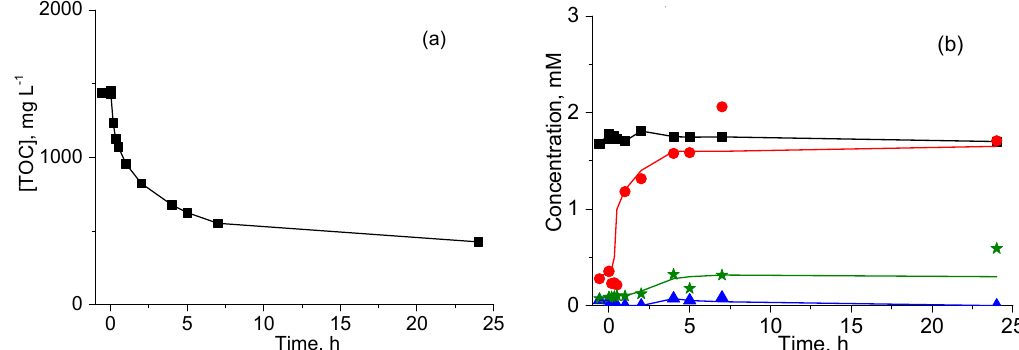
Figure 2. Evolution of: ( a ) Total Organic Carbon (TOC) and ( b ) concentrations of Total Nitrogen (TN) (measured by TOC-TN apparatus) and different N-species (analyzed by ionic chromatography) during oxidation of diluted VBC in the absence of a catalyst: TN ( ■ ), NH 4+ ( • ), NO 3- ( ), and NO 2- ( 7 ). At time zero, after introduction of air at the reaction temperature, TOC concentration was,